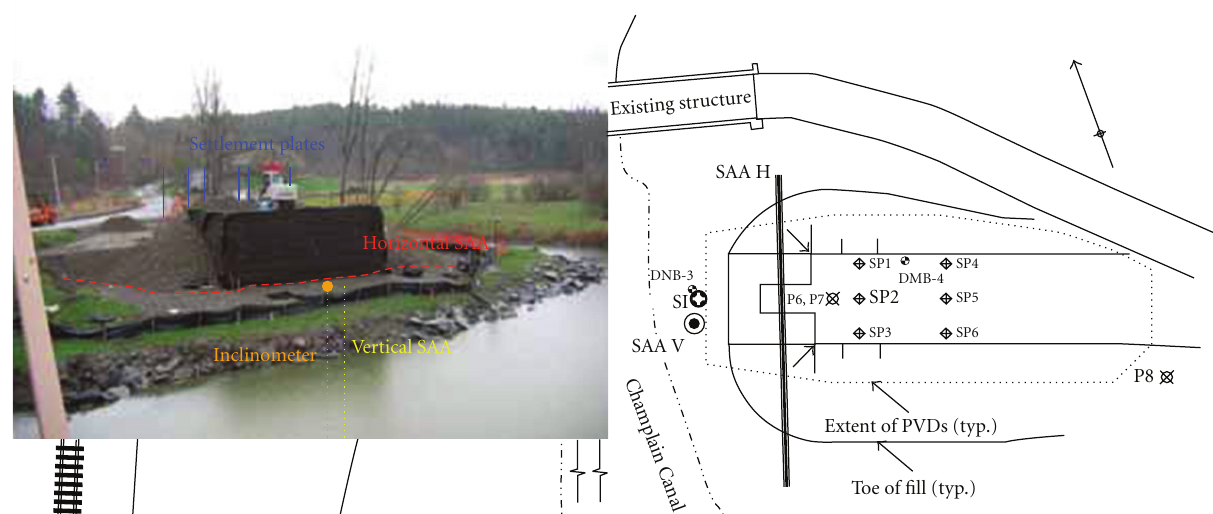
Figure 4: Bridge replacement and realignment over the Champlain Canal,